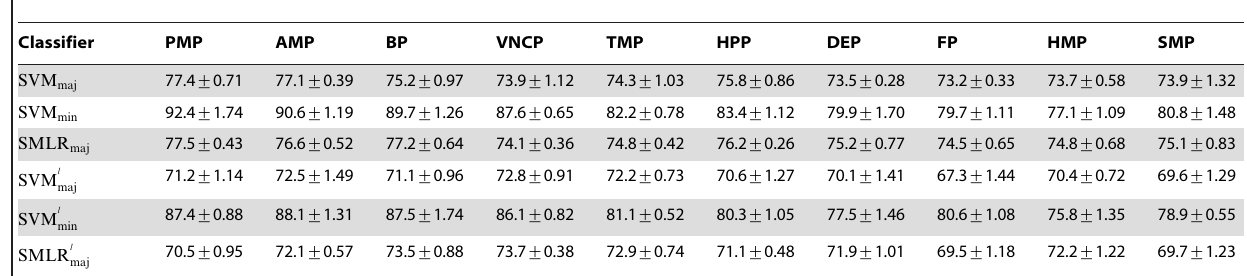
Table 1. Annotation performance in terms of AUC (mean and standard deviation), using the LOO-CV scheme, data set S 11 { 12 .